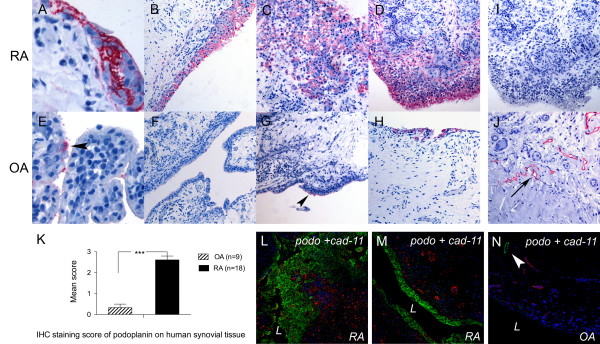
Podoplanin is expressed in human synovial tissue in RA. Immunohistochemistry (IHC) of human synovial tissue from (A-D, I) rheumatoid arthritis (RA), (E-H, J) osteoarthritis (OA) (A-D, E-H, J) using antipodoplanin antibody (D2-40) or (I) mouse immunoglobulin G1. (J) Positive control showing lymph vessels (arrow). (K) IHC staining score of podoplanin on human synovial tissue from 18 RA and 9 OA patients. Double immunofluorescence staining of (L and M) RA and (N) OA synovium using antipodoplanin (green) and anti-cadherin-11 (red) antibodies. Note the extensive hyperplasia of the podoplanin-positive lining layer cells (C and D, L) and the podoplanin-positive lymph vessel (arrowhead in N) but negative lining layer in OA (N). L, lumen. ***statistical significance P < 0,0001.